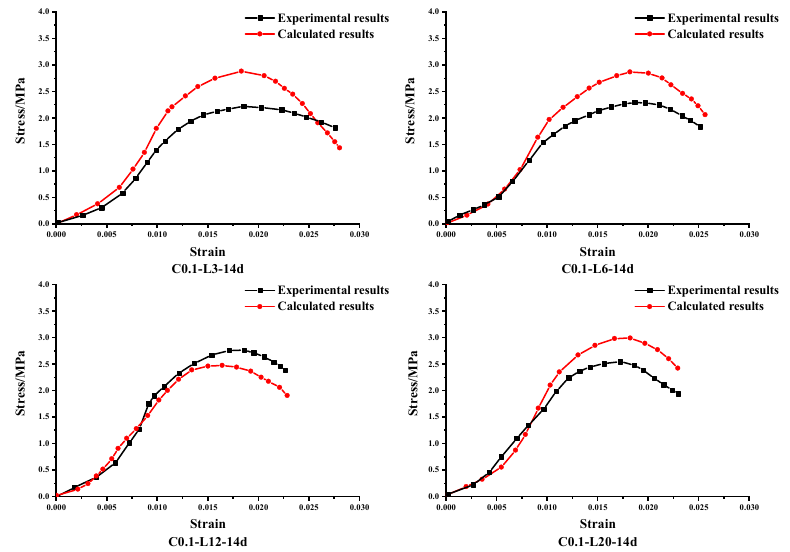
Figure 14. Comparison of the calculation results obtained by the constitutive model with the experimental results of stress-strain curves of BFRCS subjected to curing for 14 days.